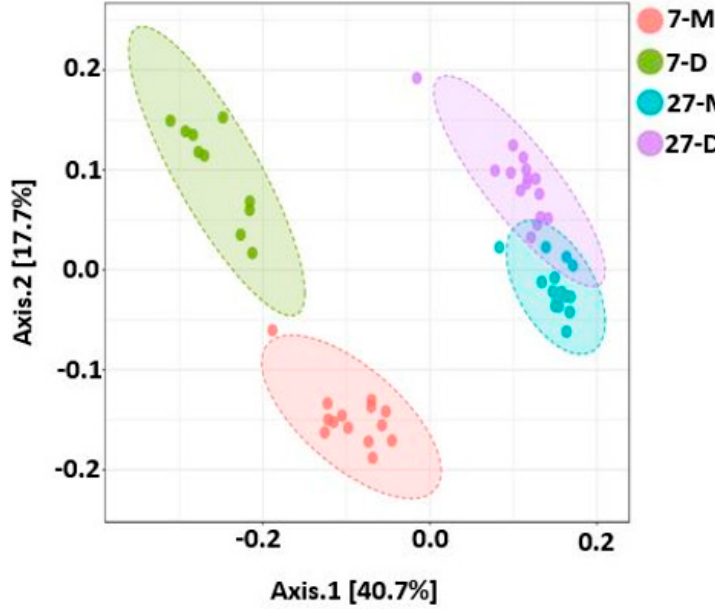
Figure 12. PCoA plot showing significant difference in bacterial community structure in different locations of GIT at two post-weaning ages of piglets (ANOSIM: R = 0.78, p < 0.001 for all four groups; R = 0.86, p < 0.001 for 7 days; R = 0.38, p < 0.001 for 27 days). Unweighted UniFrac distance metric was used to create PCoA plot. The 7 and 27 represent 7 and 27 days, respectively, after weaning; M and D represent mucosa and digesta samples, respectively.